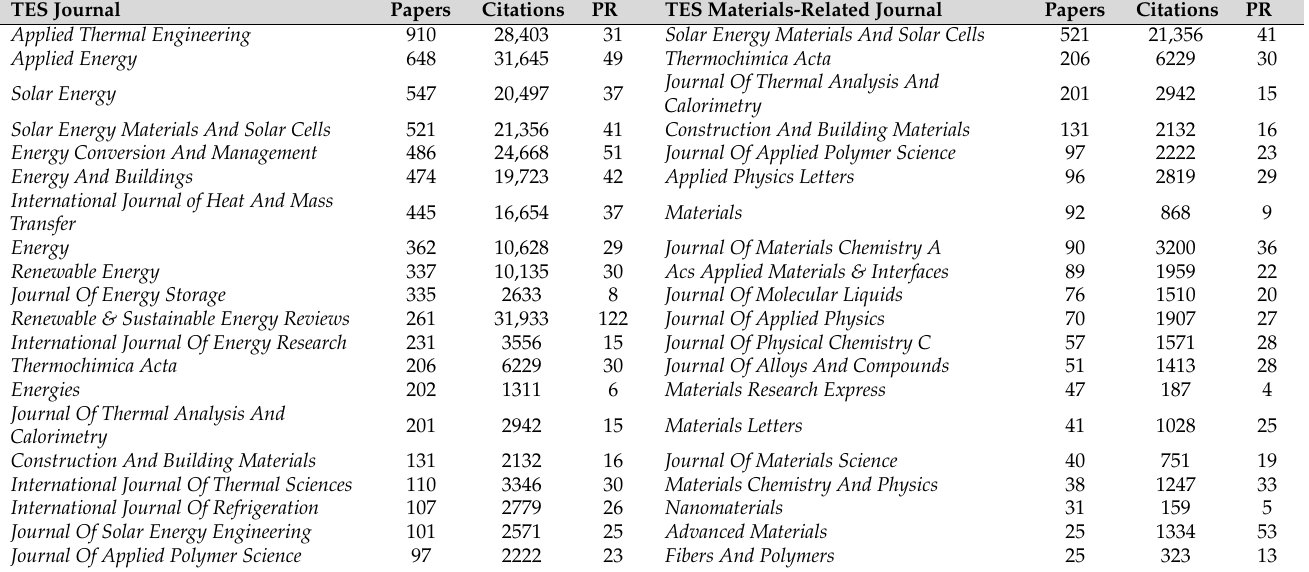
Table 2. Scientific dissemination of TESM over the last two decades, the top 20 journals (with the most publications) on the scope of TES and TESM, with the number of papers, citations and performance ratio